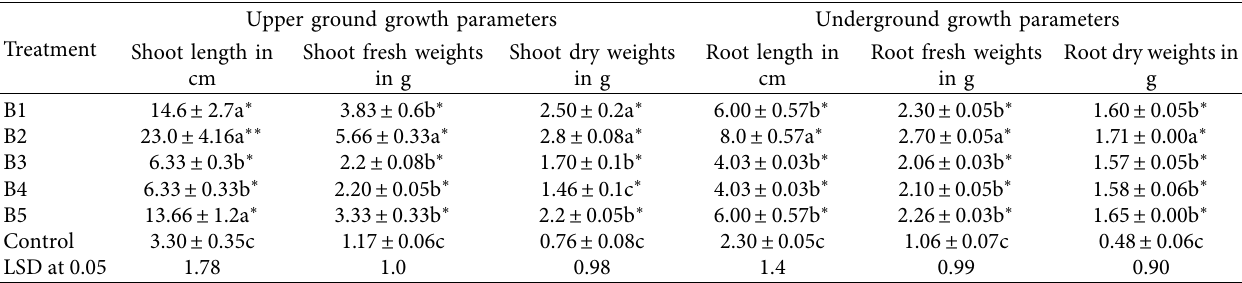
Table 5: The effect of Bacillus isolates on the growth of tomato variety Maya seedlings. Treatment